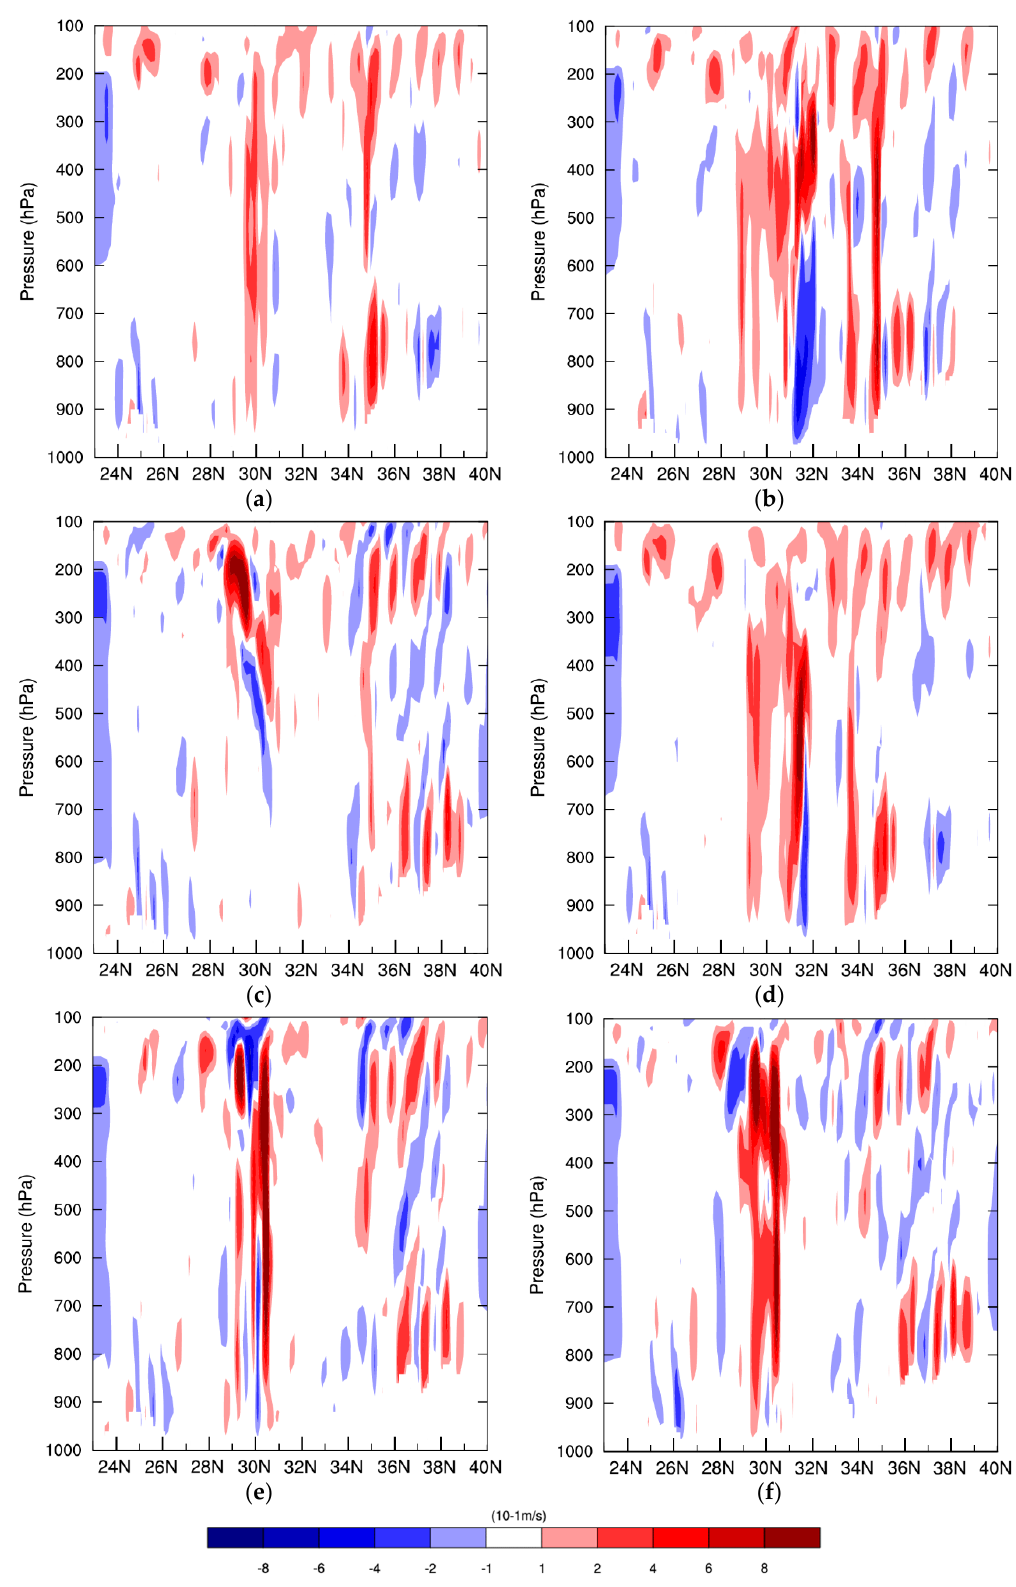
Figure 14. Cross-sections along 113 ◦ E of 6 h forecasts ( a , c , e ) and 12 h forecasts ( b , d , f ) for conv4dvar ( a , b ), pcp4dvar ( c , d ), and convpcp4dvar ( e , f ) initialized at 0600 UTC 05 July 2013 for vertical velocity (shaded; 10 − 1 m /